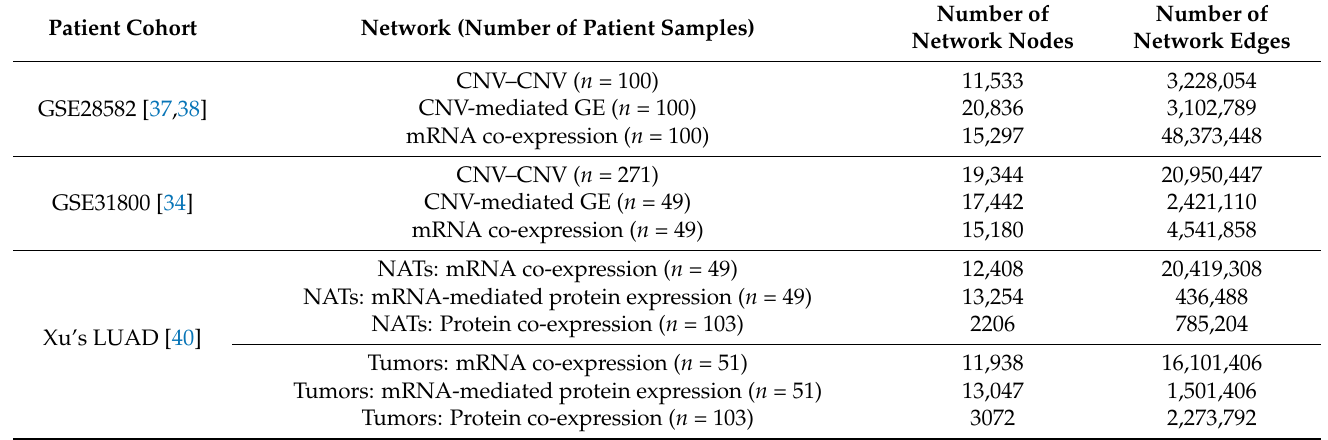
Table 1. Information of multi-omics networks in tumor samples from non-small cell lung cancer patients. The network nodes are genes and network edges are computed gene associations (one-tailed z tests, p < 0.05, 95% confidence